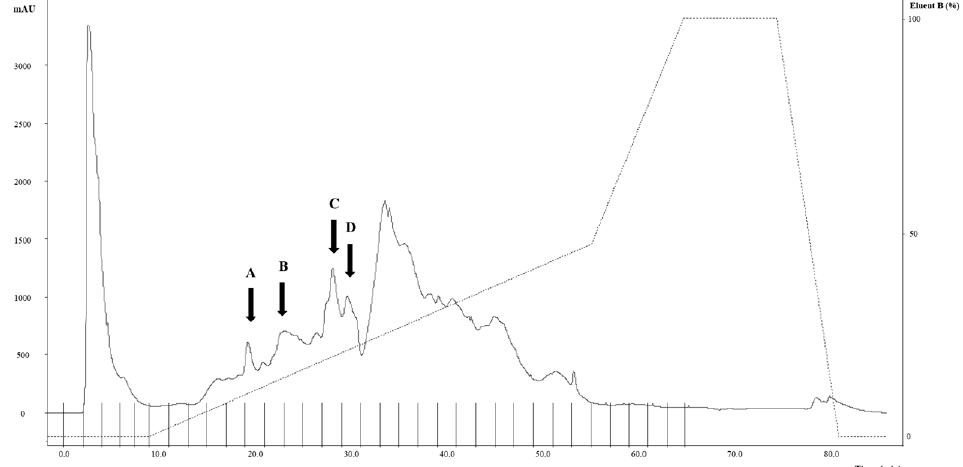
Figure 1. RP-FPLC chromatogram (UV detector 214 nm) showing the WSE fractions obtained from